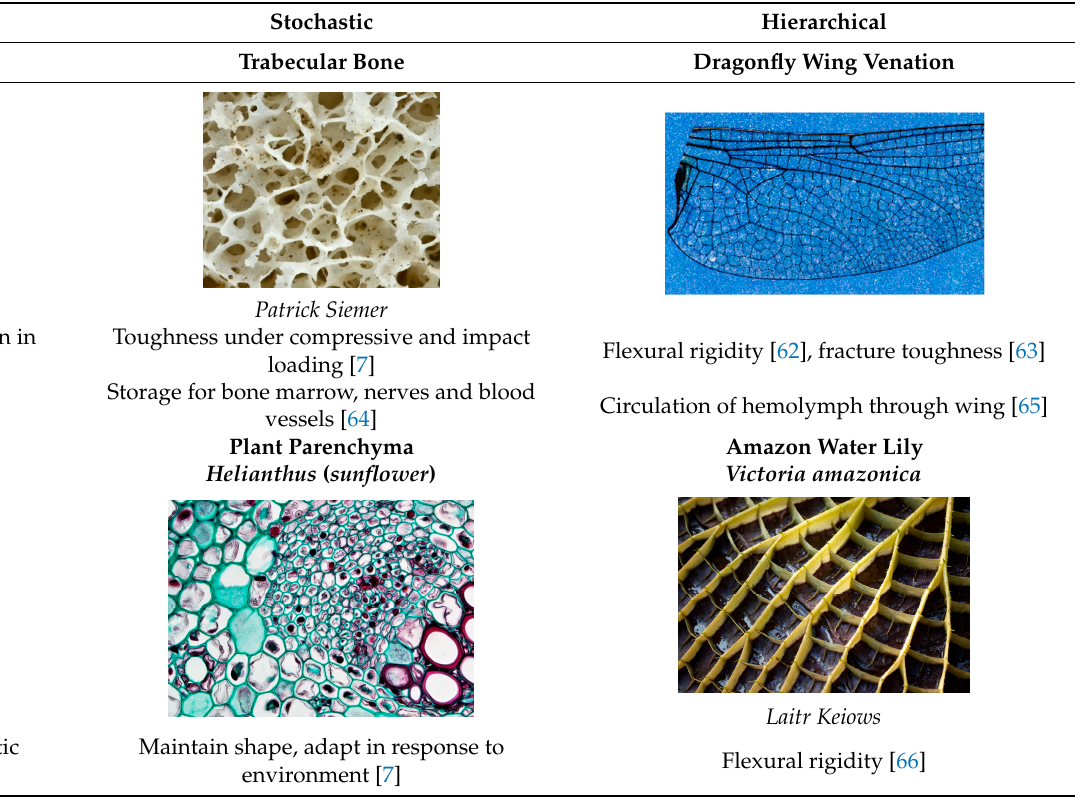
Table 3. Natural examples of periodic, stochastic and branching tessellation.